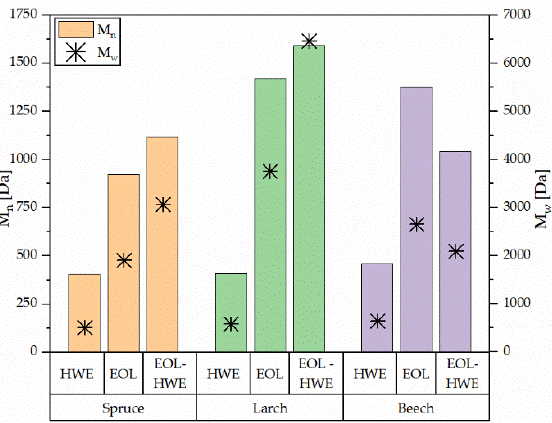
Figure 8. Weight average (Mw) and number average (Mn) molecular mass of obtained bark extracts.